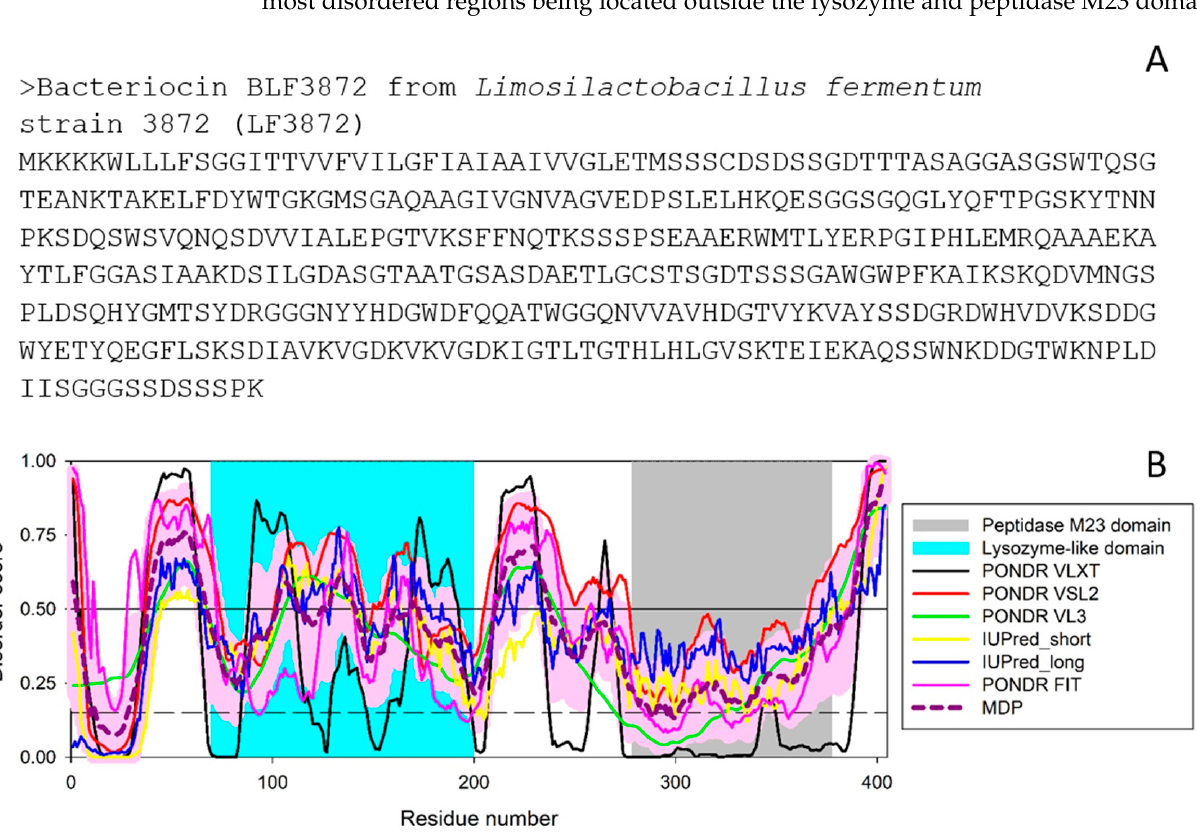
Figure 2. ( A ). Amino acid sequence of the bacteriocin BLF3872. ( B ). Intrinsic disorder predisposition evaluated using RIDAO [48] that aggregates the results from a number of well-known disorder pre- dictors: PONDR ® VLXT (black line), PONDR ® VLS2 (red line), PONDR ® VL3 (green line), PONDR ® FIT (pink line), IUPred2_long (blue line), and IUPred2_short (yellow line). A thick dashed dark- pink line represents the mean disorder prediction (MDP) profile calculated by averaging the outputs of these six predictors, whereas a light pink shadow shows the corresponding error distribution. The results of residual disorder propensity estimation using these tools are presented as real num- bers from 0 (ideal order prediction) to 1 (ideal disorder prediction). To identify disordered residues and regions in the proteins of interest, a threshold of ≥ 0.5 was used. Solid and dashed horizontal lines at disorder scores 0.5 and 0.15 correspond to the disorder and flexibility thresholds. ( C ).